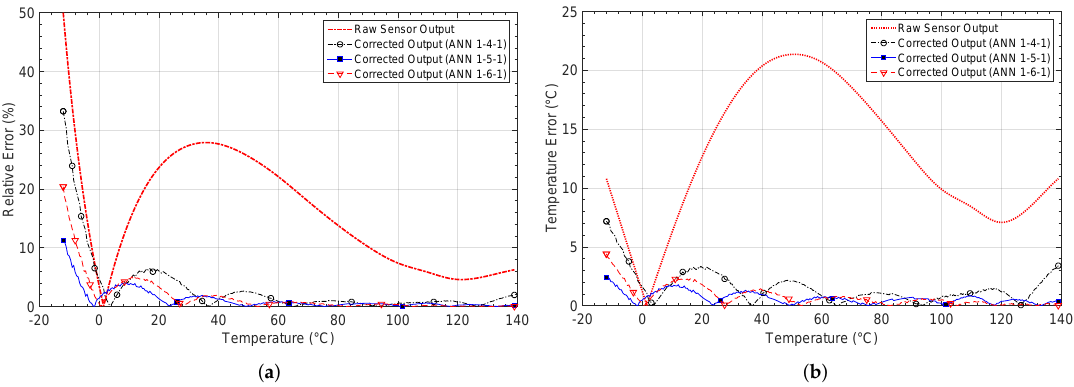
Figure 11. Calculated errors by considering the non-linear characteristic 1 (NL1): ( a ) relative error e r and ( b ) temperature estimation error e T .